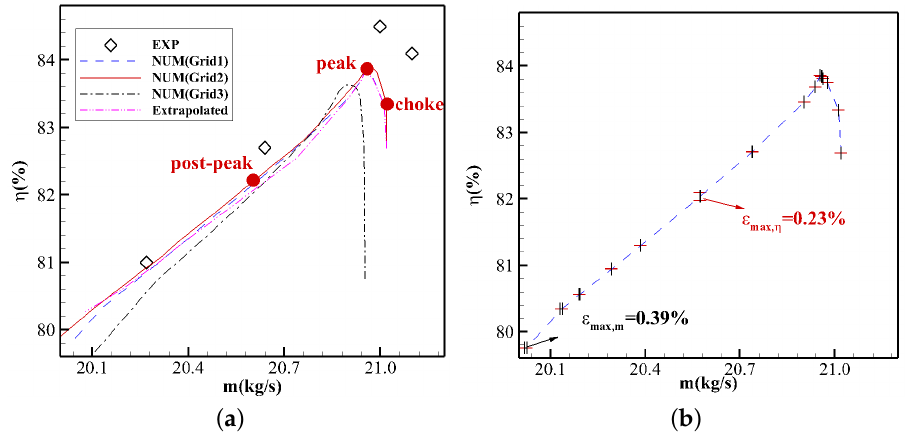
Figure 10. Isentropic efficiency against the mass flow rate at 100% design speed ( a ); Fine-grid solution, with discretization errors computed using the corresponding equations in reference [32] ( b